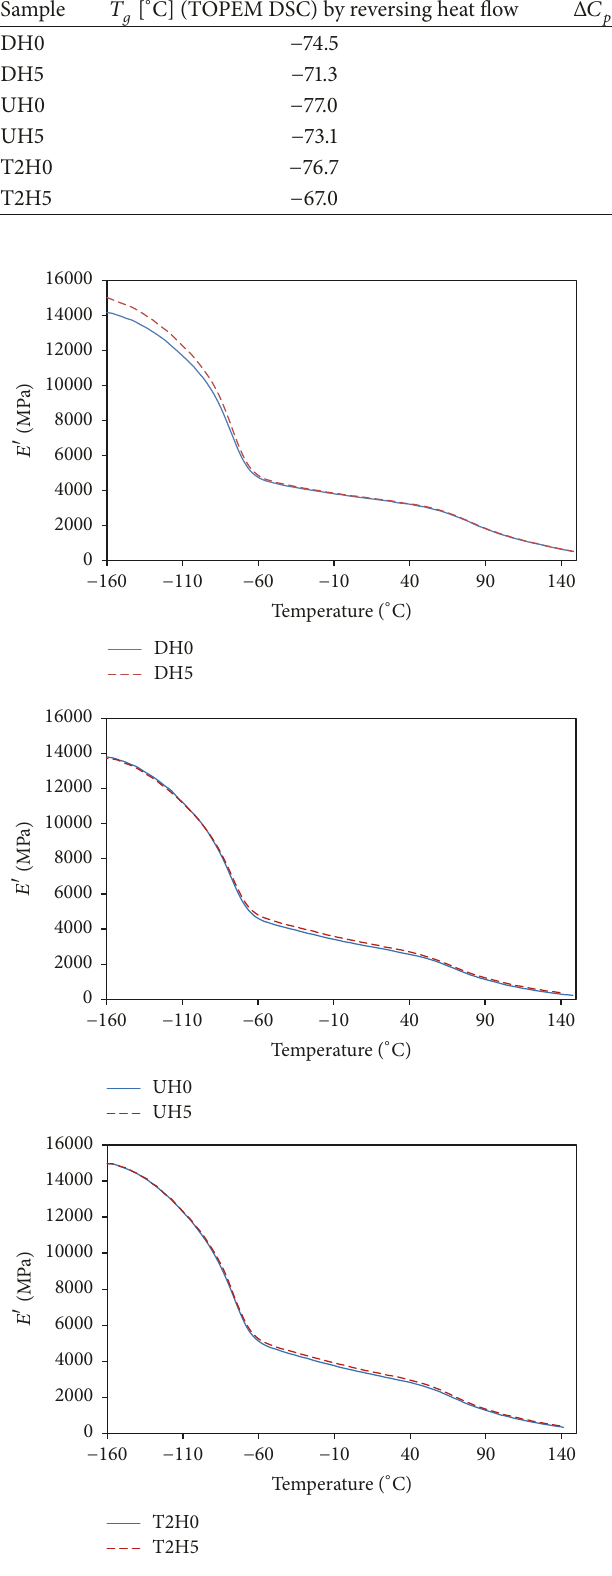
Figure 2: DMA curves for POM and POM/5% HAp nanocompos- ites: 𝐸 󸀠 versus temperature.